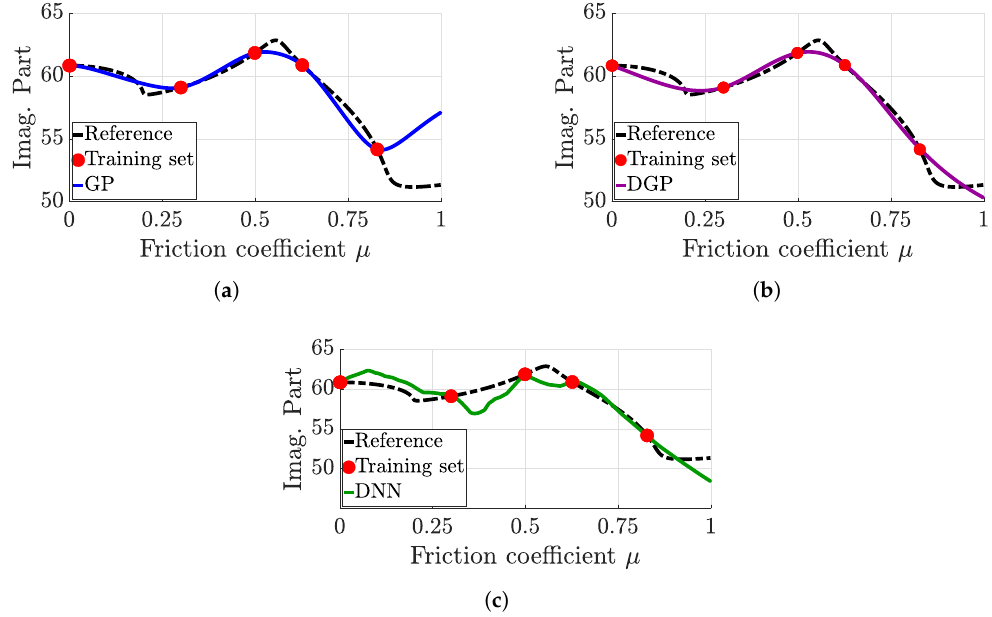
Figure 11. Comparison of each surrogate model prediction for a faulty DNN setting. ( a ) Gaussian process ( 6 samples ), ( b ) deep Gaussian process ( 6 samples ), ( c ) deep neural network ( 6 samples